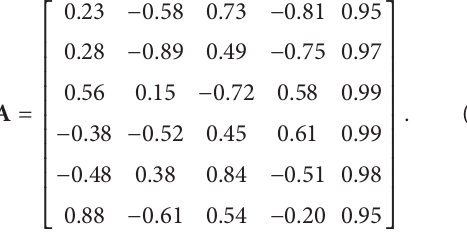
Each correlation coefficient 𝜌 𝑖𝑗 in Ω 𝑊 = {𝜌 𝑖𝑗 } indicates the similarity between the separated component 𝑖 and the source = {𝜌 } , the elements 𝑗 . From the correlation matrix Ω 𝑊 𝑖𝑗 in the diagonal show the correlation coefficients between the separated components and related source signals: the correlation coefficient of s 1 ( s 2 , s 3 , s 4 , and s 5 ) and related separated component 1 (2, 3, 4, and 5) is 0.99 , which indicates that all the source information of s 1 ( s 2 , s 3 , s 4 , and s 5 ) has been completely separated from the mixed signals by the ICA algorithm. The high correlation coefficients indicate that the ICA algorithm can effectively separate the mixed signals into independent components for the given sources and linearly mixed mode. However, the correlation coefficients